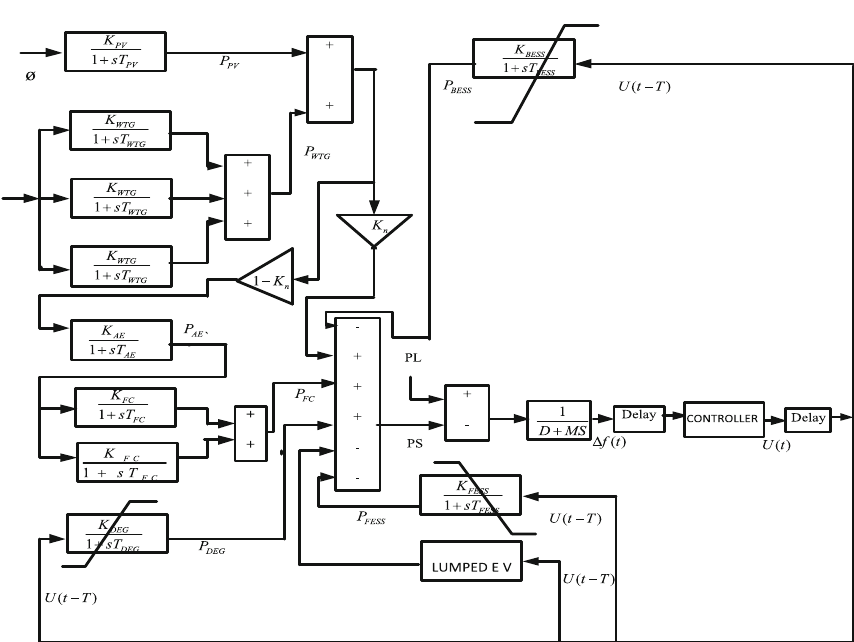
Fig. 1 Hybrid power system under